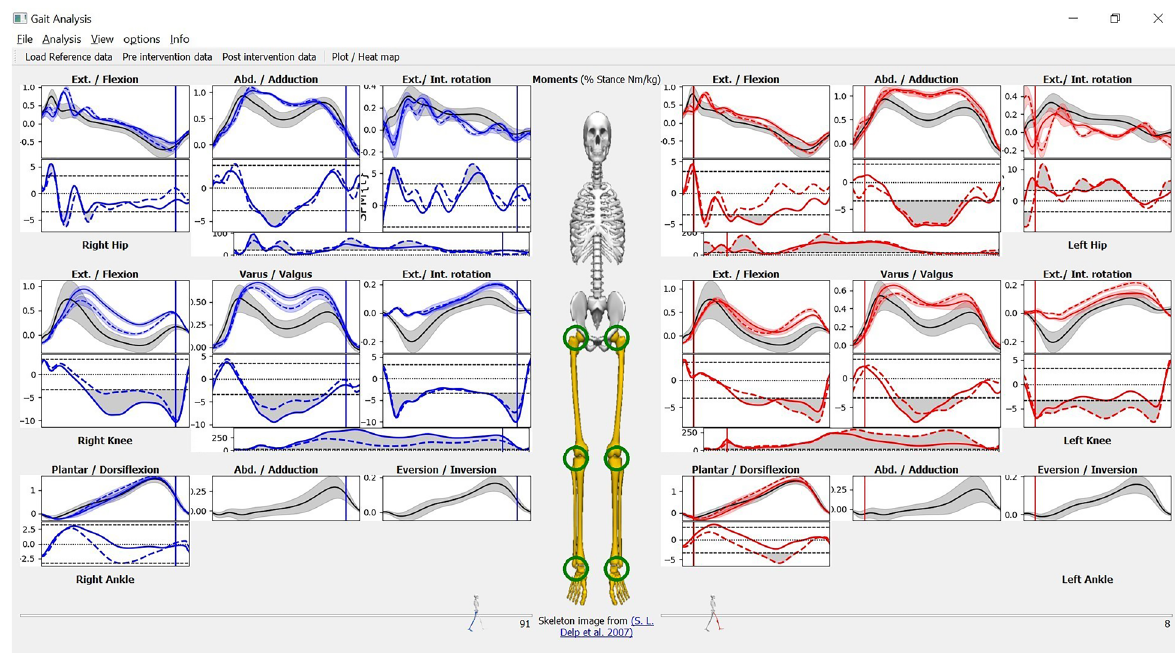
Figure 6. Plot of individual components, showing the same case of Fig. 3 after switching to the plot